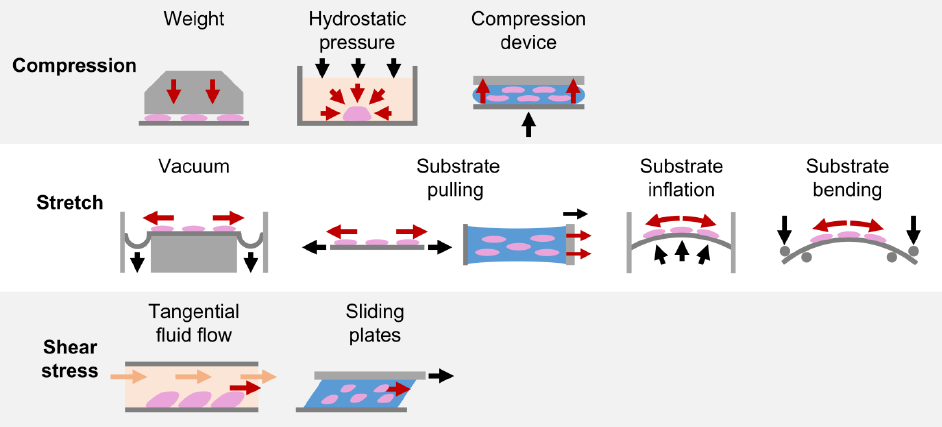
Figure 5. In vitro mechanical loading methods applied for PDL investigations. Schematic represen- tation of the in vitro mechanical loading methods adopted in the reviewed studies for exposing PDL cells cultured in 2D layers or in 3D constructs to compression, stretch, and shear stress